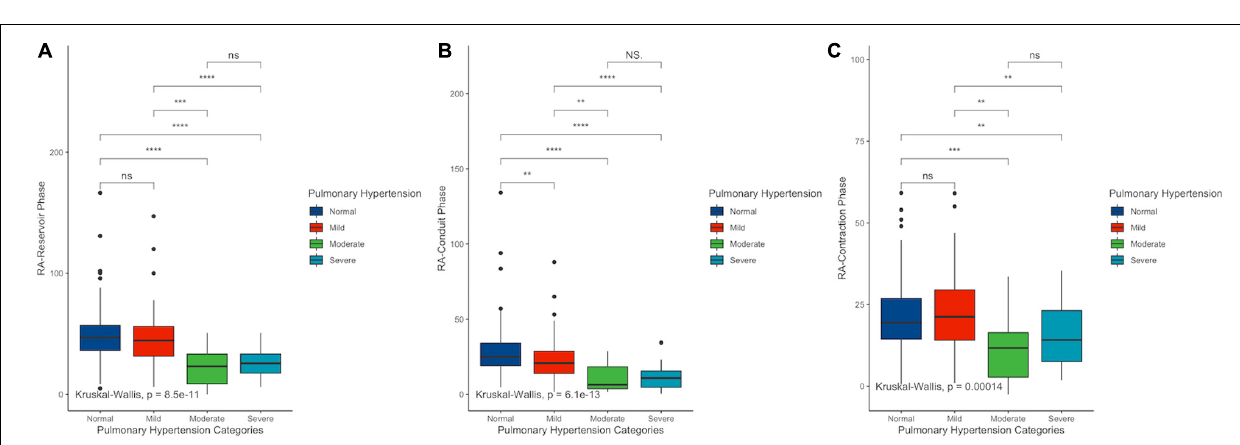
FIGURE 5 | Differences among right atrial reservoir (A) , conduit (B) , and contractile (C) phases in PH categories. sPAP, systolic pulmonary arterial pressure; RV-FWS, right ventricular free wall strain; RA-GS, right atrial global longitudinal strain. ** p < 0.01, *** p < 0.001, and **** p <